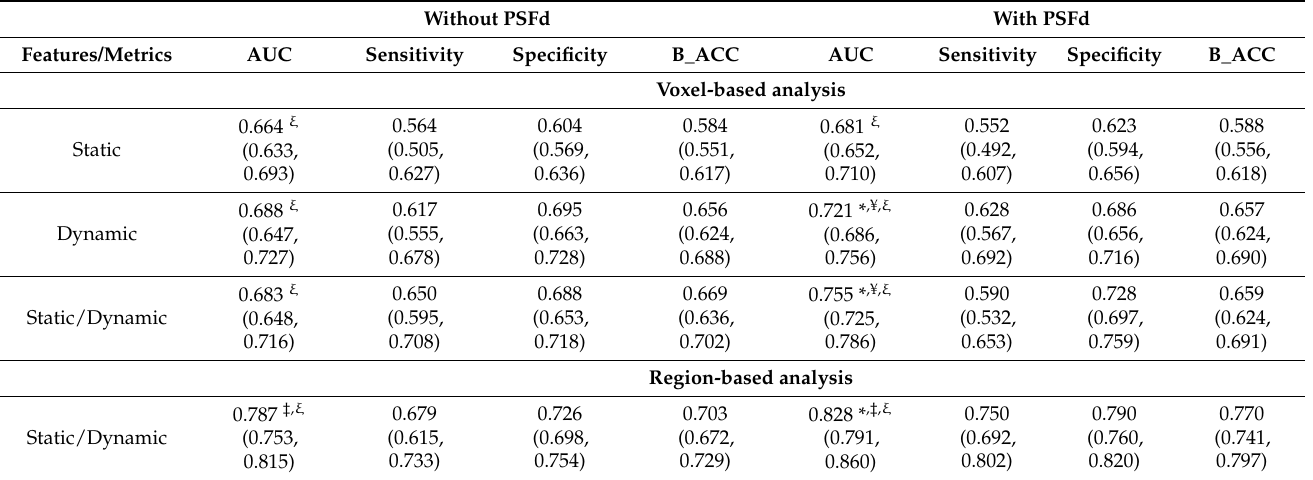
Figure 3. Shapley additive explanation (SHAP) values representing feature importance to substantiate at least 50% of the IDH-mutation prediction model (for voxel-based ( A ) and region-based ( B ) analysis) trained on the static/dynamic feature set. Common features between the two PSFd statuses are highlighted in red. Subscript TTP indicates that the relevant feature is extracted from the dynamic TTP parametric map. PSFd: point spread function deconvolution; TTP: time-to-peak; NGLDM: neighboring grey level dependence matrix; GLCM: grey level co-occurrence matrix. Table 3. Model performance on the test set for 1p/19q codeletion